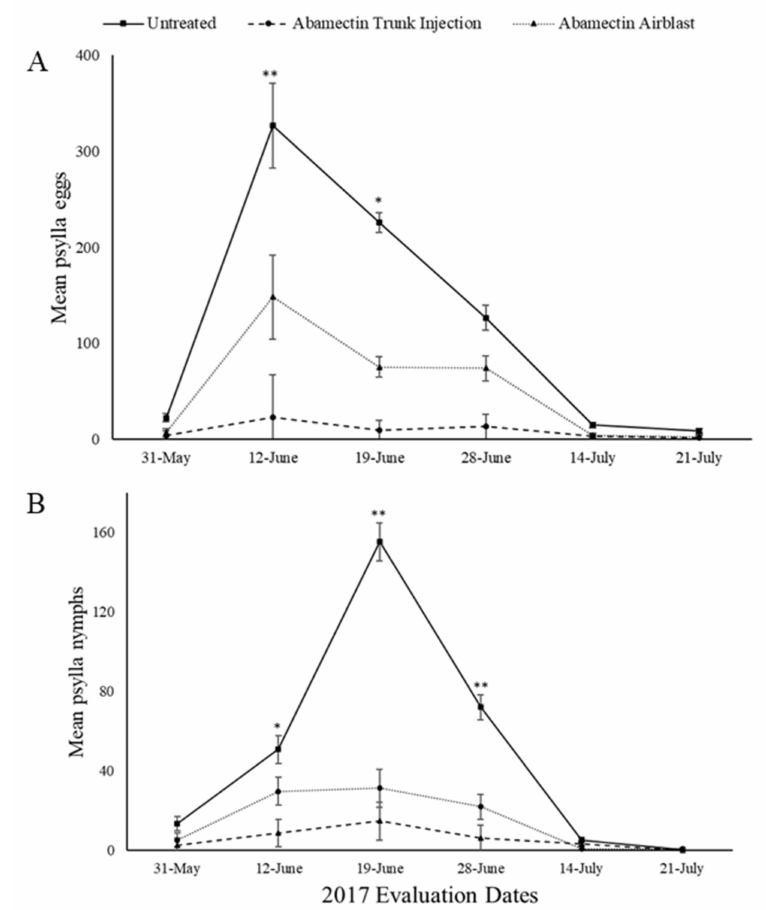
Figure 2. Mean number of pear psylla eggs ( A ) and nymphs ( B ) per 50 leaves in 2017 evaluations for the untreated and abamectin treatments. Values with * above them represent a significant di ff erence ( p ≤ 0.05) between the untreated and the trunk injected treatment only. Values with ** above them represent a significant di ff erence ( p ≤ 0.05) between the untreated and both injection and airblast